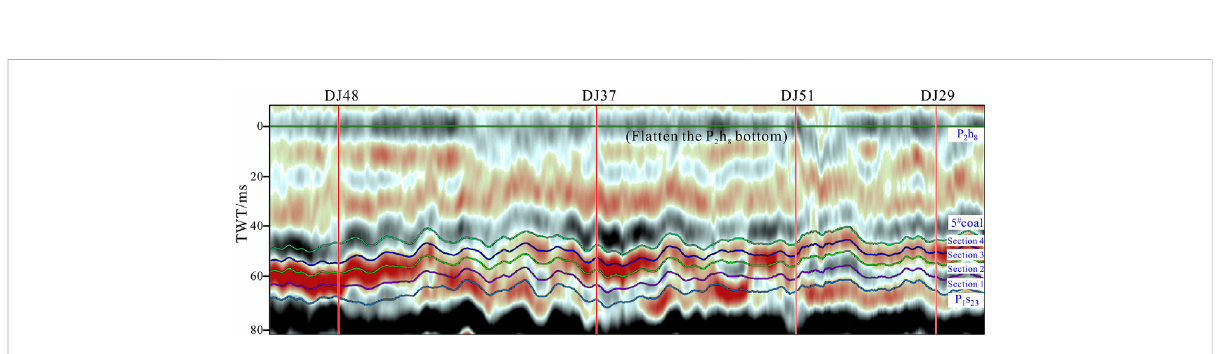
FIGURE 3 Seismic pro fi leofconnectingwellsoftheShanxiFormation intheeasternOrdosBasin.(FlattenthebottomoftheShihezi Formation,P 2 h 8 isthe bottom boundary of the Shihezi Formation, No. 5 coal is the top boundary of the Shan-2 Lower Sub-member, and P 1 s 23 is the bottom boundary of the Shan-2 Member.)